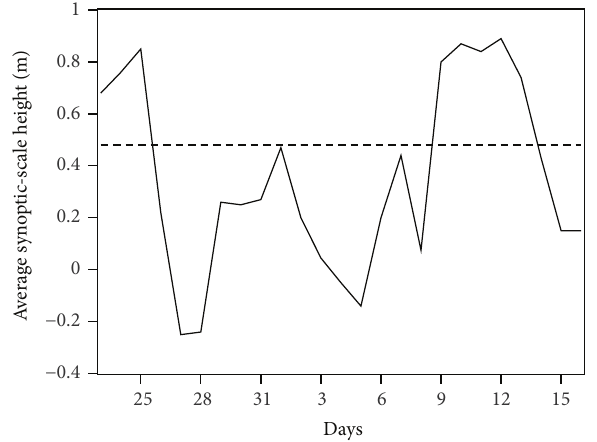
Figure 9: Synoptic-scale 500hPa geopotential heights (m) for January 23–February 16. The horizontal line represents monthly